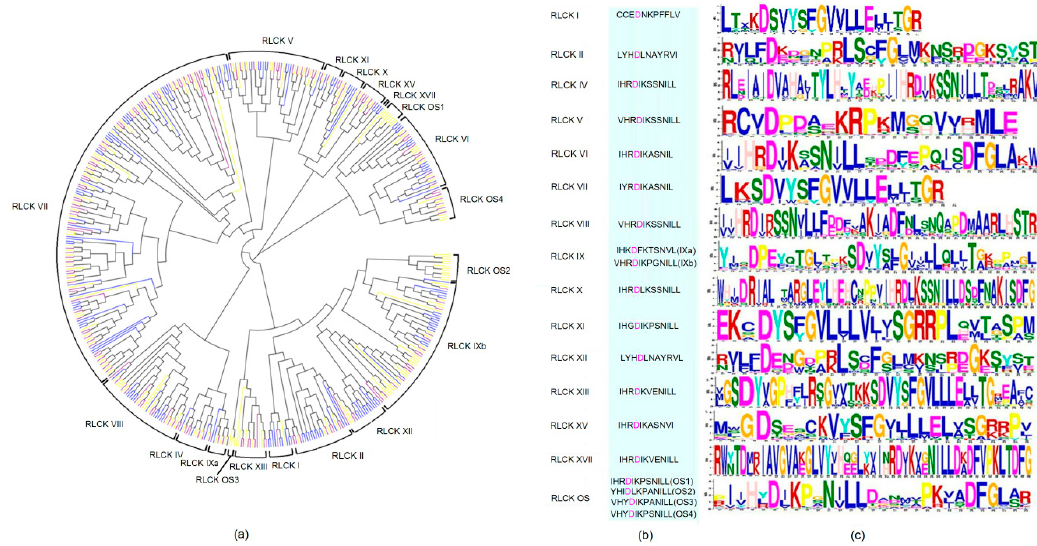
Figure 1. The phylogram and conserved kinase domain analysis of receptor-like cytoplasmic protein kinases (RLCKs) in maize, rice, and Arabidopsis. ( a ) The RLCK phylogram of maize, rice, and Arabidopsis. The pinkish purple, yellow, and blue were used to show the RLCK genes from maize, rice, and Arabidopsis, respectively. ( b ) The conserved kinase domain of RLCKs in each group. The pink letters were the predicted kinase activity sites of RLCKs. ( c ) The RLCK conservative motifs in each group.